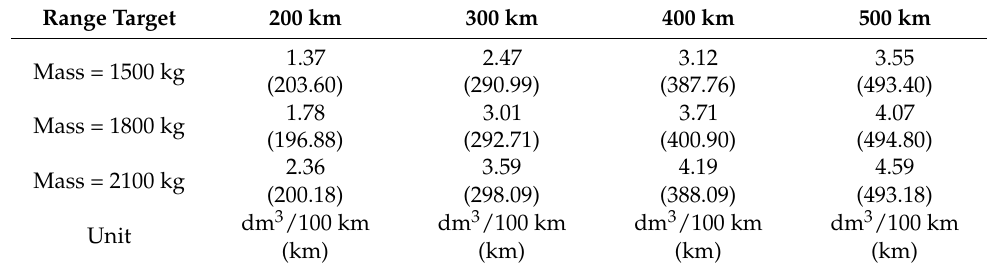
Table 17. Fuel consumption in EREV mode for